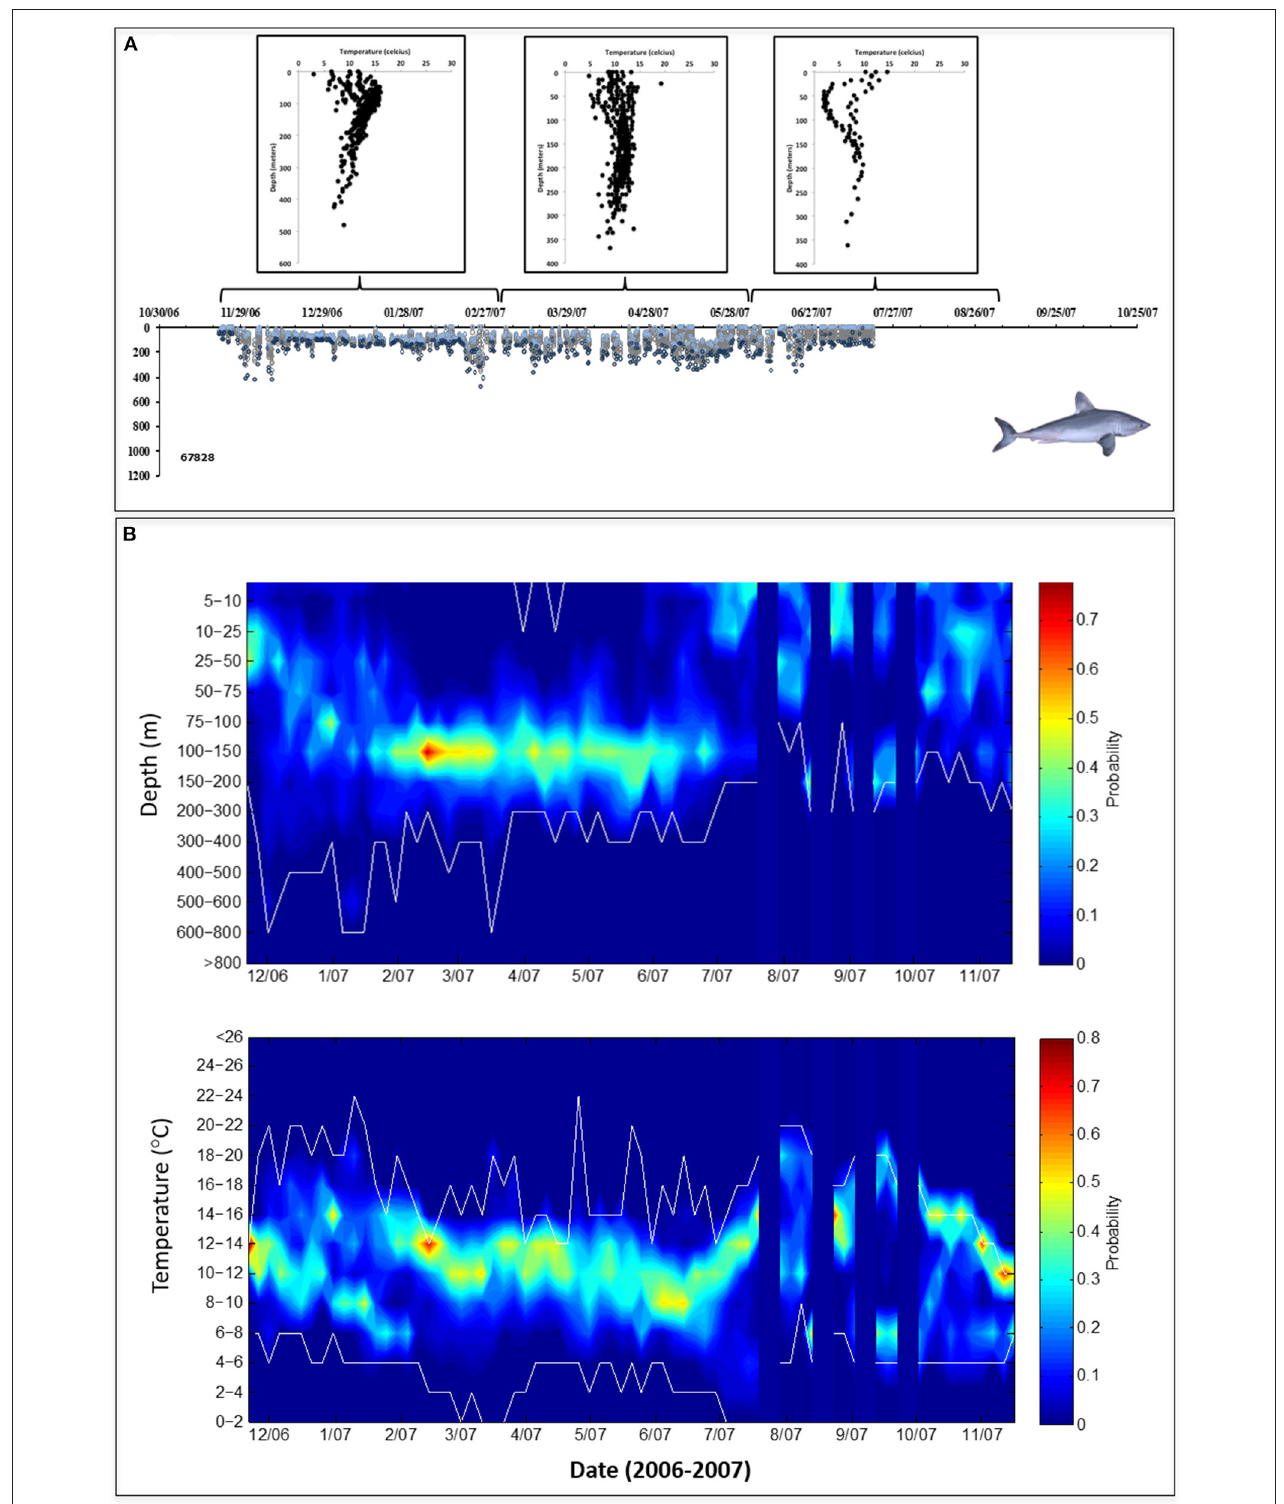
FIGURE 3 | (A) Vertical behavior of a representative “non-diver” porbeagle (Shark 4, PTT 67828) showing depth-temperature profiles at 3-month intervals (upper) corresponding to daily depth observations (lower) comprised of minimum (light blue circles), maximum (dark blue circles), and intermediate (gray circles) depths. (B) Contoured probability plots of all depth (upper) and water temperature (lower) data collected from porbeagles classified as non-divers ( n = 7); white lines indicate upper and lower limits of the data and blue vertical bars indicate areas of missing data.